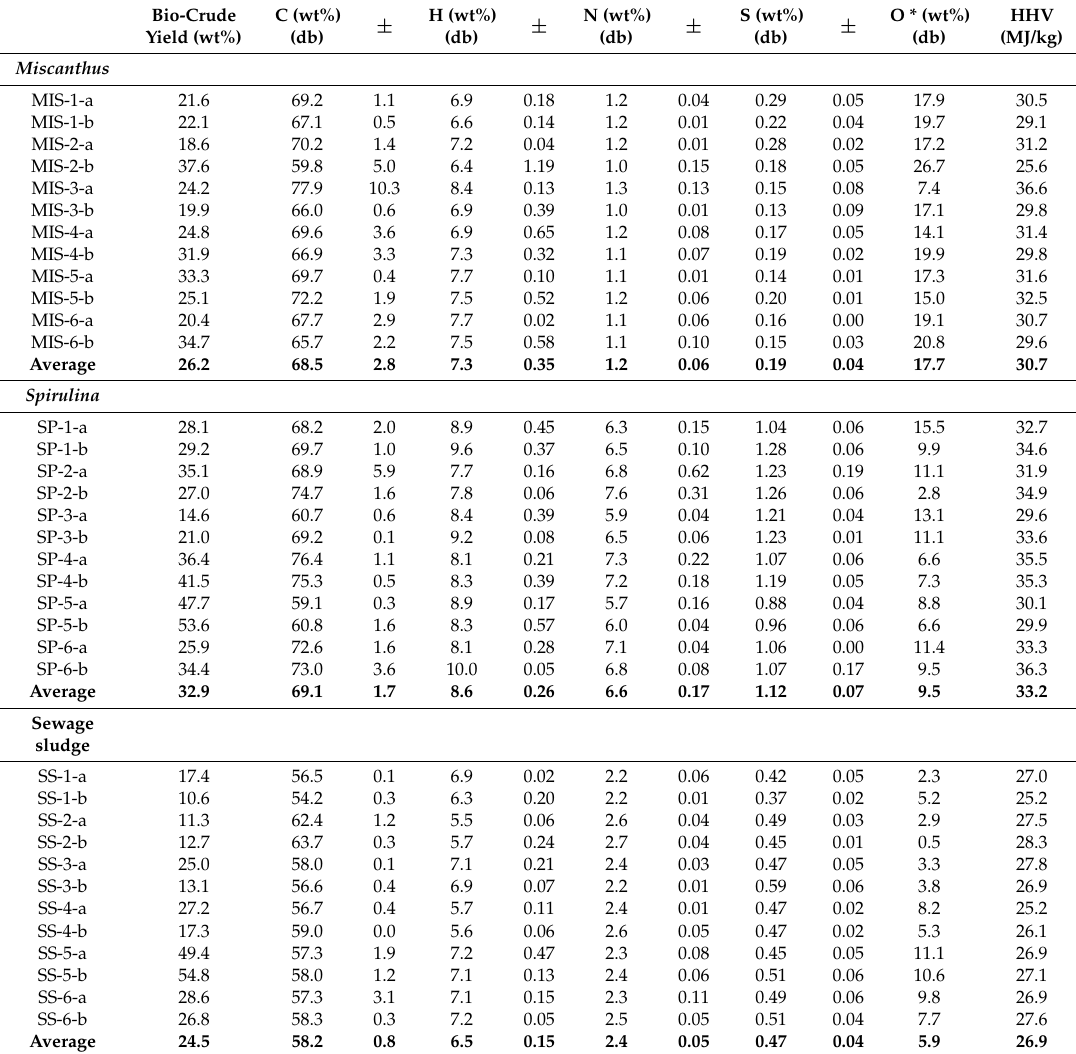
Table 4. Yields, ultimate analysis and HHVs of bio-crudes from HTL of Miscanthus (MIS), Spirulina (SP) and sewage sludge